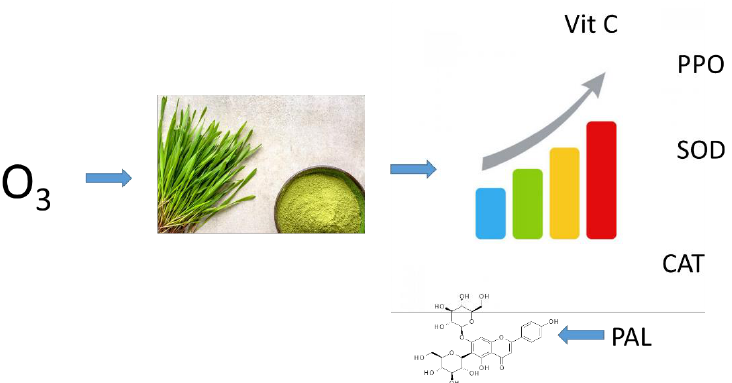
Figure 1. Proposed mechanism of trioxygen induced biosynthesis antioxidant molecules in young barley.